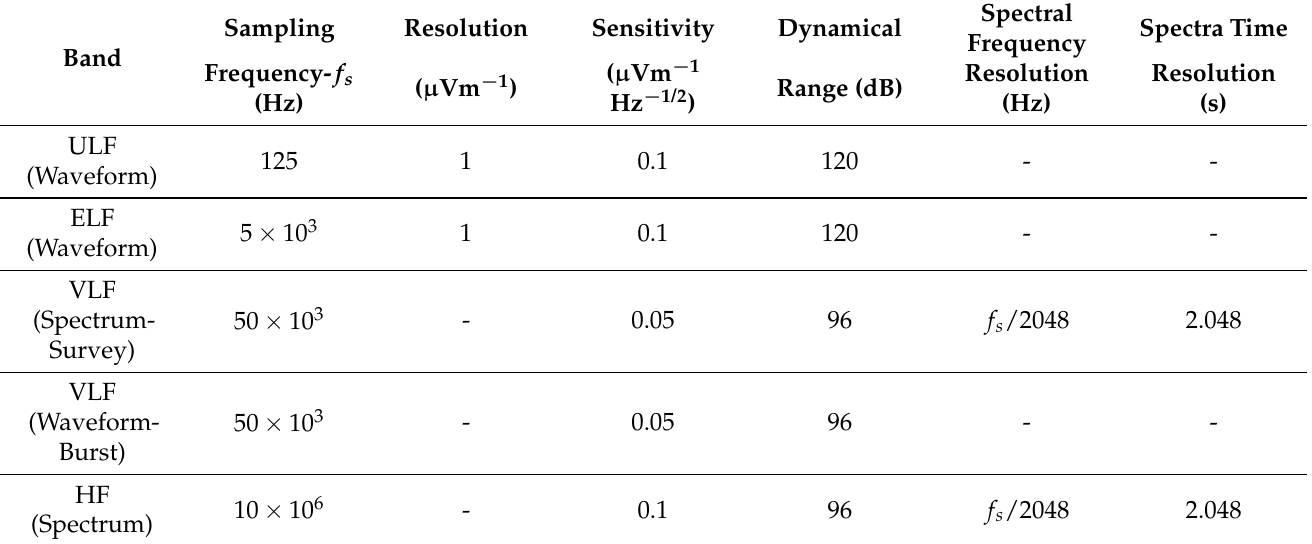
Table 2. Characteristics of the EFD for the different frequency bands